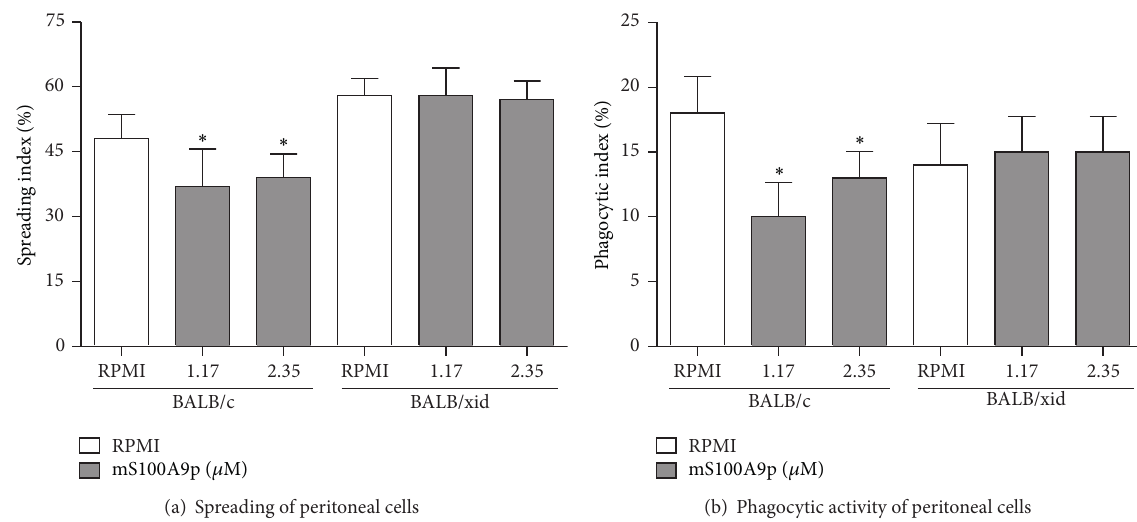
Figure 1: Spreading and phagocytosis assays by peritoneal cells obtained from BALB/c and BALB/xid mice after incubation with mS100A9p. (a) Peritoneal cells were adhered to coverslips (1 × 10 5 cells/well) and incubated with mS100A9p (1.17 or 2.35 𝜇 M in RPMI-1640 medium), for 1h at 37 ∘ C in 5% CO 2 . Control adherent cells were incubated only with culture medium. (b) After spreading, cells were incubated with 1 × 10 6 Candida albicans particles for 1h. Results are expressed as means ± SD, using six animals per group. ∗ 𝑃 ≤ 0.05, when compared to the respective control group (RPMI).